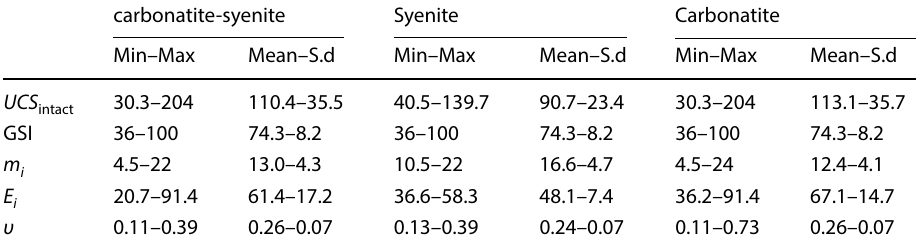
Table 10 The mean and standard deviation values of geomechanical parameters for the syenite, carbonatite and carbonatite-syenite